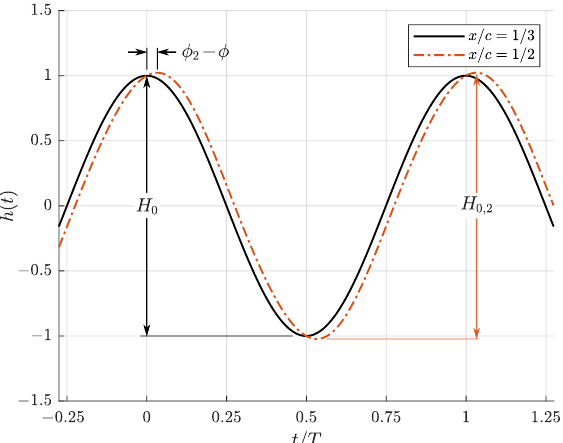
Figure 2. Heaving motion function h ( t ) of two locations along the chord ( x / c ) for a pivot location x p = c /3, showing how the new heaving amplitude and motion phase are